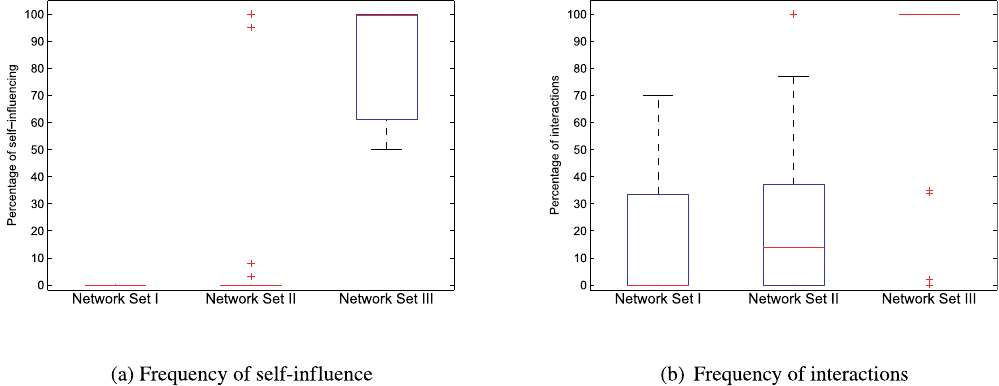
Figure 8. Initial percentage of self-influence and interactions in network sets. By examining real networks and dynamical systems, we get unequivocal results of structural differences. ( a ) Network Set I does not exhibit self- influence, and Network Set II does not exhibit them except in four cases, and only two of them exhibit more than 8% of self-influencing edges in their topologies. In contrast, more than 50% of self-influencing interactions in Network Set III are observed, i.e. more than half of the state variables influence themselves in dynamical systems. The median is almost 100%, so these dynamics are usual in dynamical systems. ( b ) In Network Set I usually less than 35% of interaction type edges are observed. In the case of Network Set II, results are a little higher. In Network Set III only four systems contain less than 100% of interactions, so in dynamical systems these dynamics is always present.